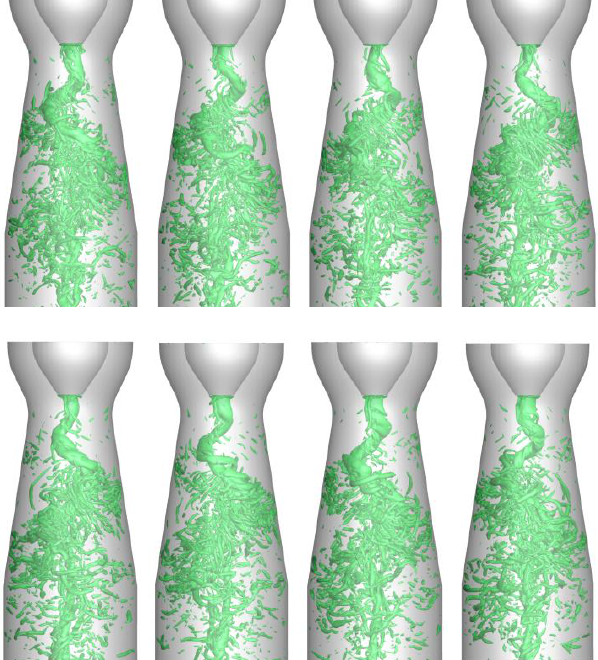
Figure 14. Shape of vortex rope at eight continuous